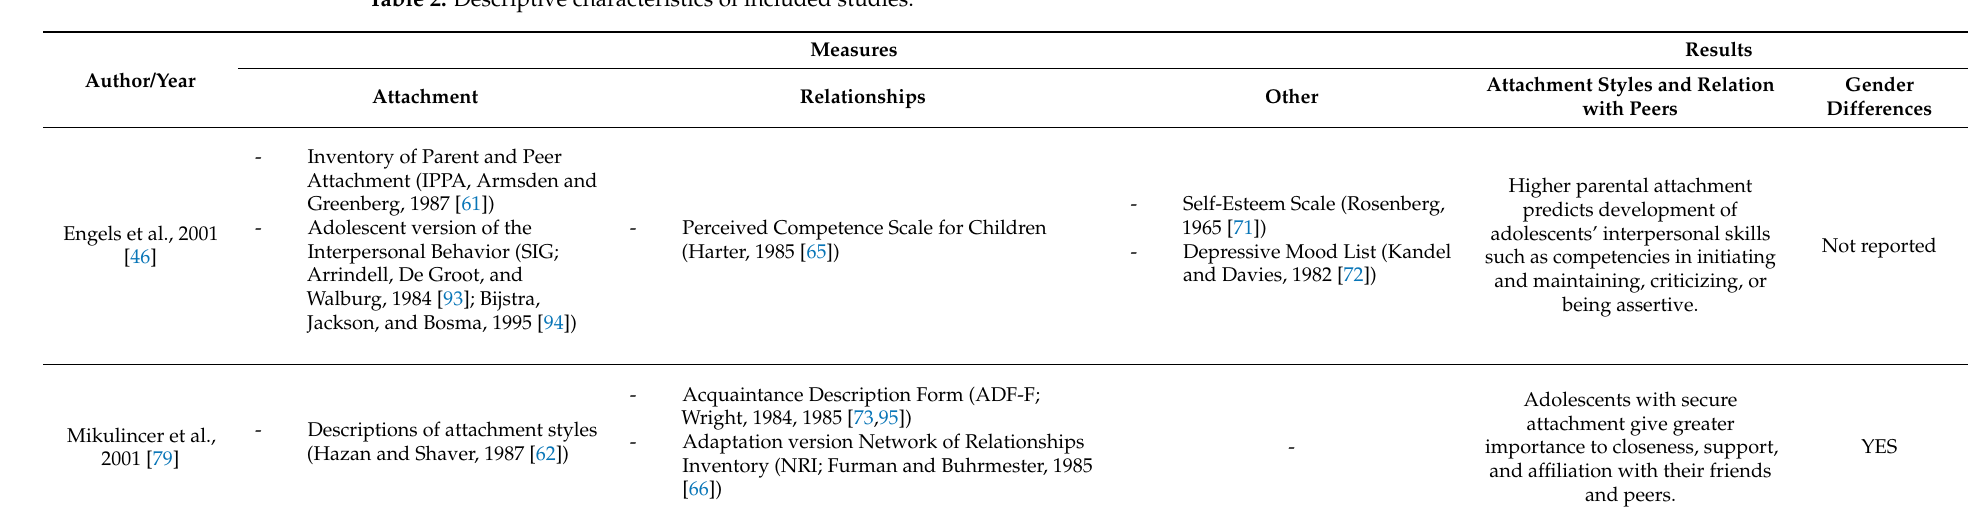
Table 2. Descriptive characteristics of included